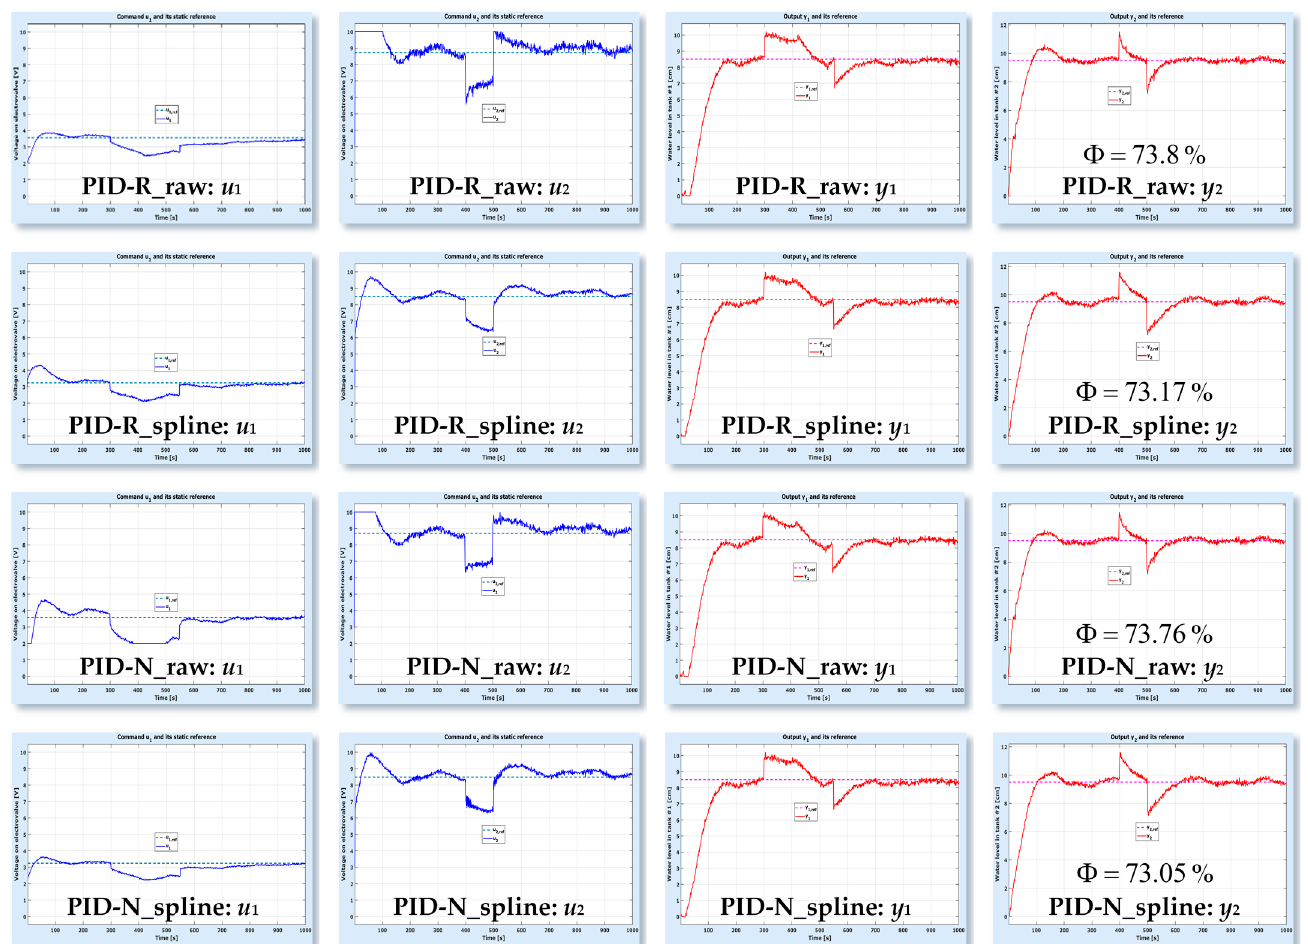
Figure 22. PID-ASTANK2 performance for constant perturbations applied on outputs.